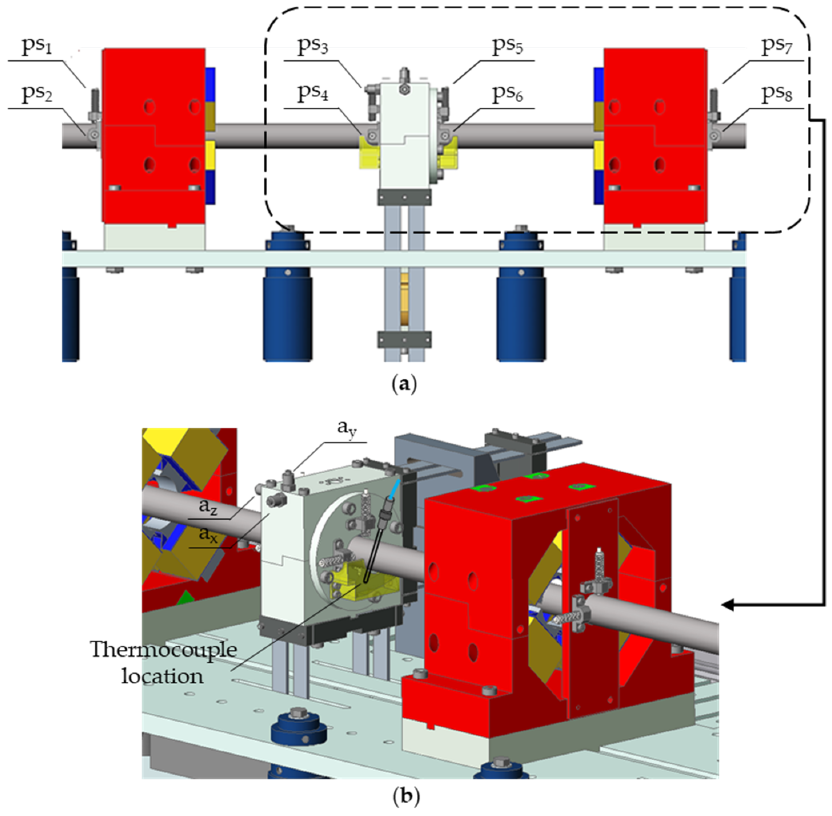
Figure 14. Locations of the ( a ) inductive proximity sensors (ps i ) and ( b ) accelerometers (a x , a y , a z ), and thermocouple for measuring the feeding temperature.